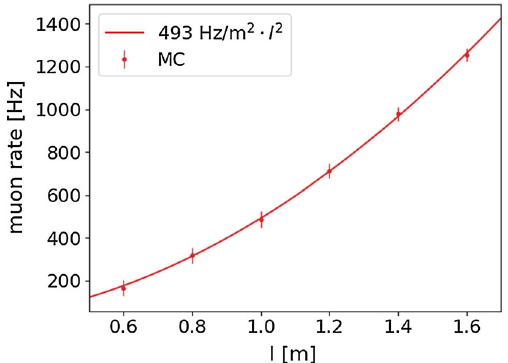
Fig. 9 Simulated rate of incident muons with 4GeV energy for a cubic muon veto at the VNS with varying edge length l . The rate shows a quadratic increase with the edge length (red line). Uncertainties are statistical